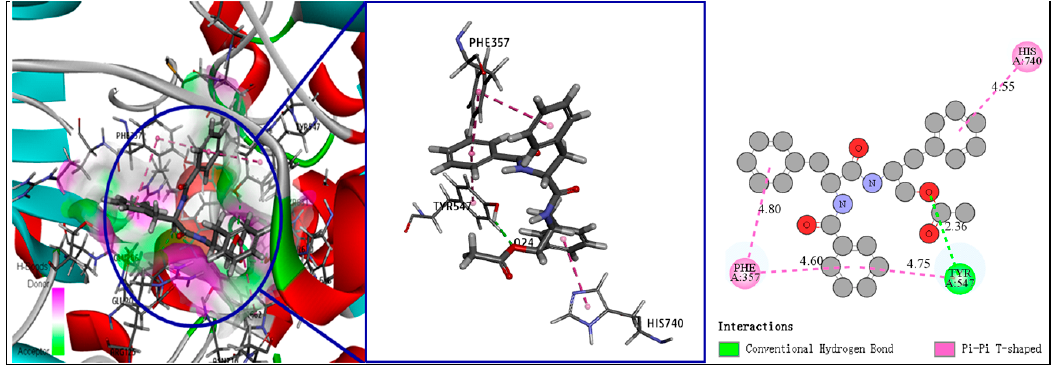
Figure 5. Receptor–ligand interaction of compound 3 with DPP-IV binding site.